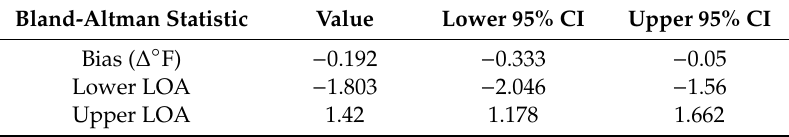
Table 3. Bland–Altman statistics for Zephyr ECT vs. Gold Standard.